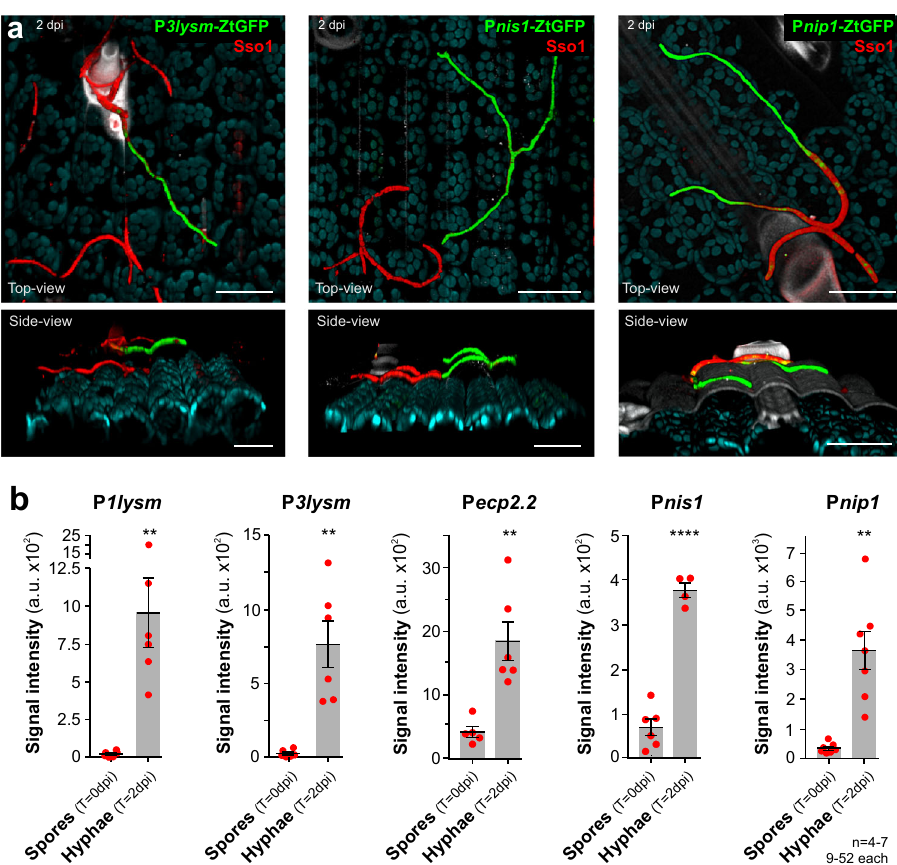
Fig. 6 | Expression of cytoplasmic GFP under the control of promoters of putativeeffectorsandnecrosis-inducingfactorsinIPO323inplanta.a Inplanta expression of GFP driven by effector 3lysm promoter (P 3lysm -ZtGFP, green; left panel), the promoter of genes, encoding a homologue of the necrosis-inducing factor Nis1 45 (P nis1 -ZtGFP, green; middle panel; FungiDB gene ID: ZTRI_9.376) or putative necrosis-inducing factor Nip1 46 (P nip1 -ZtGFP, green; right panel; ZTRI_11.358). Cells also express fl uorescent plasma membrane marker mCherrry-Sso1 (red). Top and side views of image stack reconstructions are shown. Spores show red plasma membrane, whereas switching to hyphae induces GFP fl uorescence. Chloroplasts are shown in cyan. White structure in the upper part of the image represents a leaf hair (trichome). Note that the mCherry-Sso1 signal is weak in hyphae. Scale bars=30 µ m. See Supplementary Movies 4 – 6. b Signal intensities of cytoplasmic GFP in spores and hyphae on